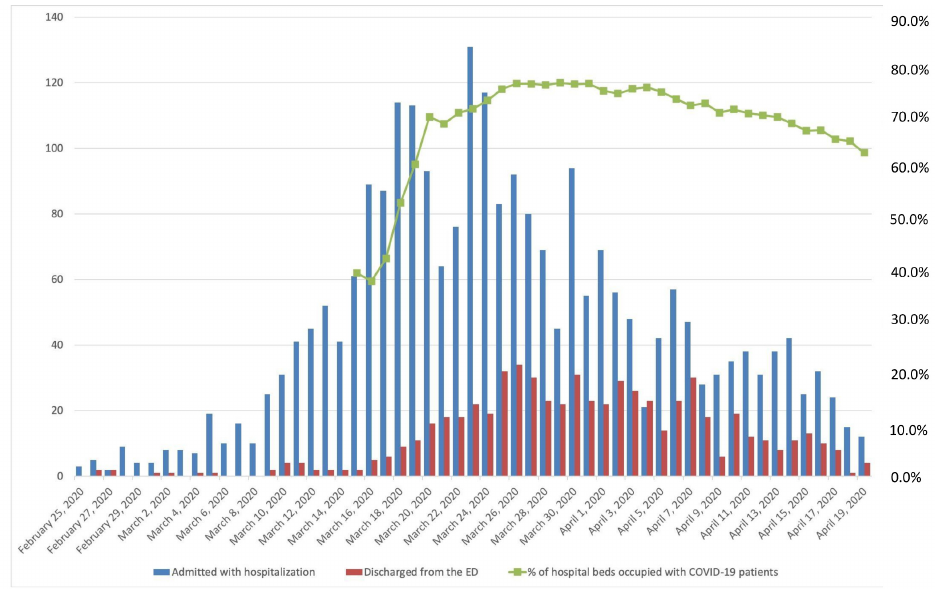
Figure 1. Patients treated by the emergency department per day between 25 February 2020, and 19 April 2020. The blue lines indicate patients admitted and hospitalized, and the red lines indicate patients discharged from the emergency department. The green line represents the percentage of hospital beds (including ICU) occupied by patients with COVID-19.